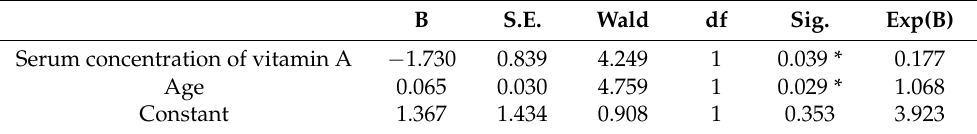
Table 2. Multiple logistic regression on the effect of age and serum concentration of vitamin A on the phenotype severity.